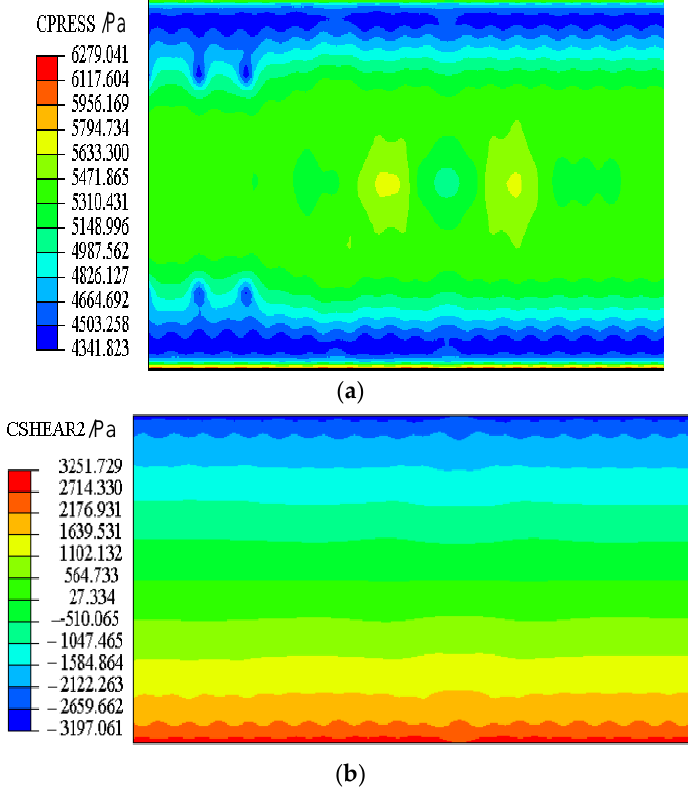
Figure 15. Interface stress. ( a ) Normal stress. ( b ) Transverse shear stress.